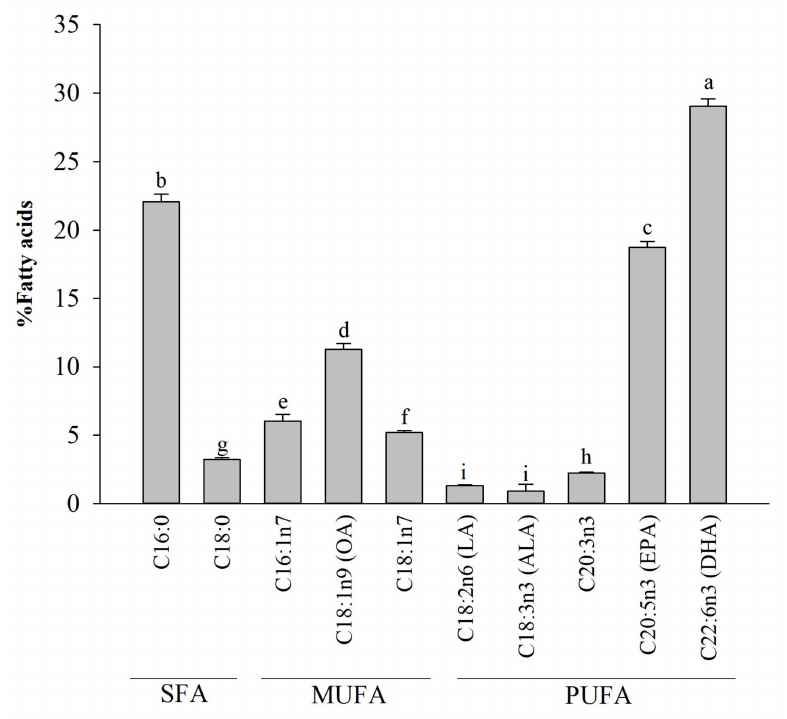
Figure 1. Fatty acid composition of A. personatus egg lipid. Data are presented as means ± standard deviation ( n = 5). The letters a, b, c, d, e, f, g, h, and i indicate significant differences ( p < 0.05) between the fatty acid levels. ALA = alpha-linoleic acid, DHA = docosahexaenoic acid, EPA = eicosapentaenoic acid, LA = linoleic acid, MUFA = monounsaturated fatty acid, OA = oleic acid, PUFA = polyunsaturated fatty acid, and SFA = saturated fatty